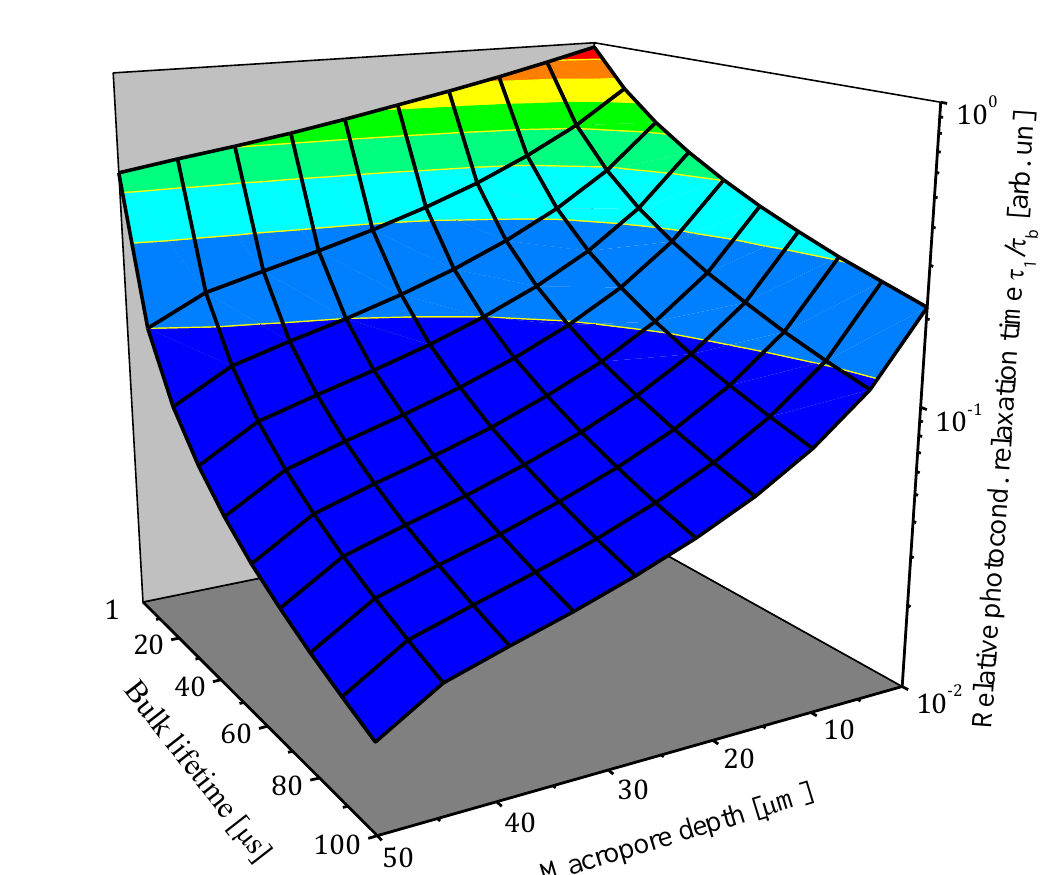
Figure 4. The dependence of the relative relaxation time of photoconductivity on the depth of the macropores and the bulk lifetime at thickness of macroporous silicon is 50